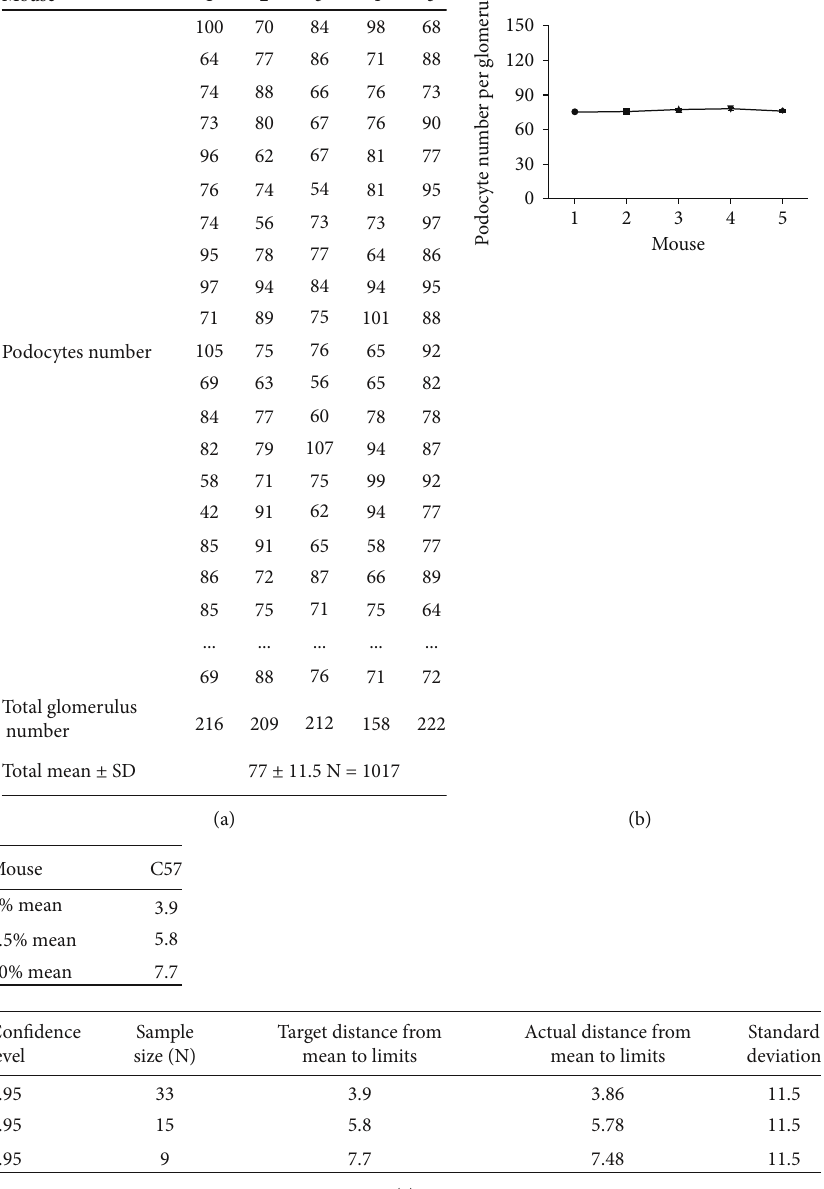
Figure 2: A limited number of glomeruli may represent the overall podocyte number in C57 mice. (a) The podocyte number per glomerulus of 1017 glomeruli in fi ve C57 mice was quanti fi ed with the Imaris software through identifying 3D reconstruction images of podocytes per glomerulus and exhibited in chart. The mean of podocyte number per glomerulus was calculated from 1017 glomeruli. The sum of podocyte number from 1017 glomeruli was used as the numerator, which was divided by the total number of glomeruli, 1017. (b) No statistical signi fi cance in podocyte number per glomerulus was observed among fi ve C57 mice, which proposed stability distribution of podocyte number per glomerulus within C57 mice. Data are expressed as mean ± SEM . (c) The tables displayed the sample size of glomeruli needed to represent the whole sample size with taking 5%, 7.5%, and 10% of the mean podocyte number per glomerulus as the statistical allowable error and setting total con fi dence level as 95% by the PASS